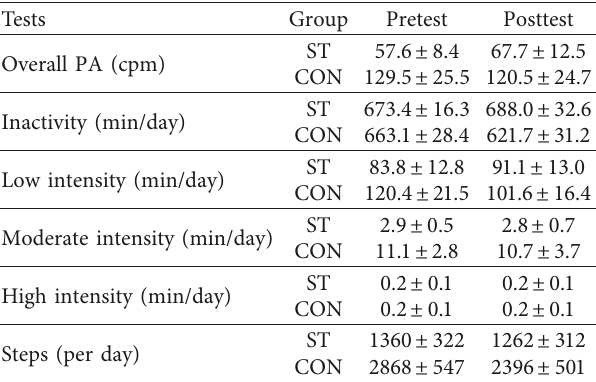
Table 3: Pre- and posttest results of physical activity for the ST and CON.